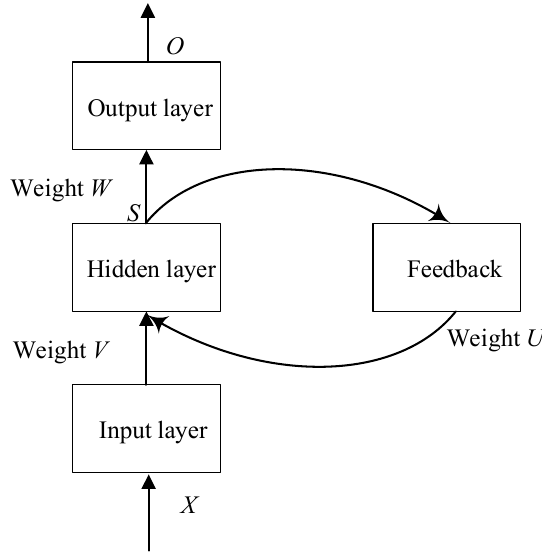
Figure 4. Structure of RNN.